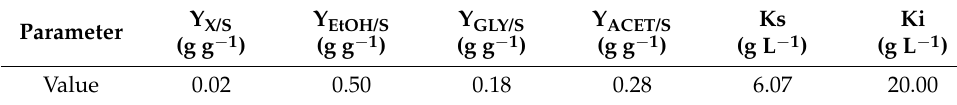
Table 2. List and values of fixed mathematical model parameters.